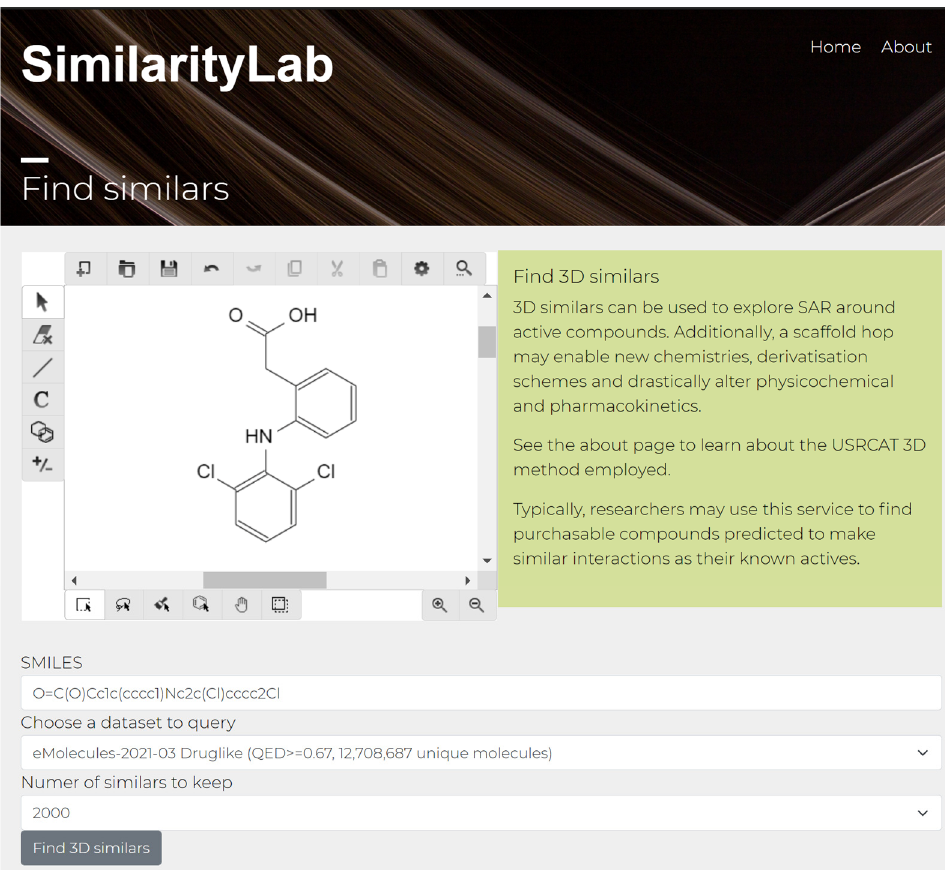
Figure 3. SimilarityLab 2D drawing interface for 3D similarity searching, shown with the approved drug diclofenac being queried.